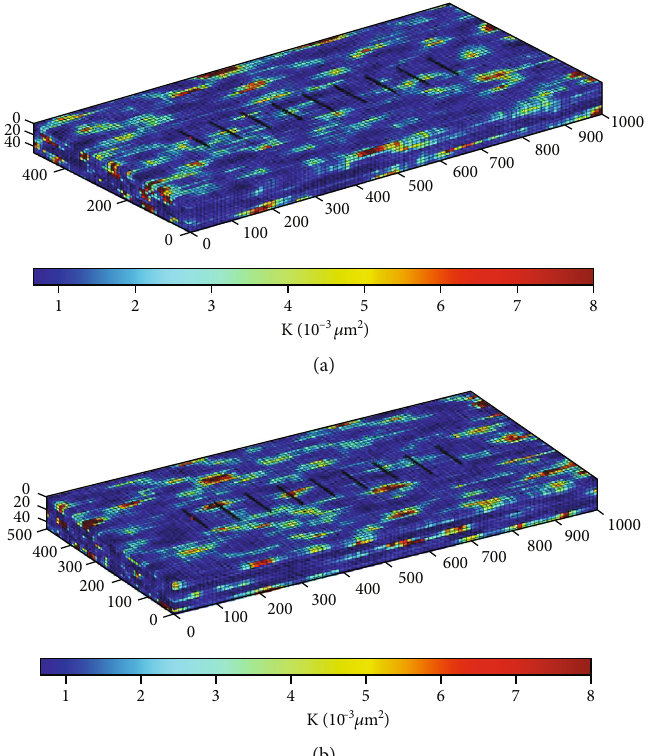
Figure 9: Permeability distribution simultaneously considering in-layer and interlayer heterogeneity: (a) and (b) are the permeability distribution (containing one and two interlayers, respectively).